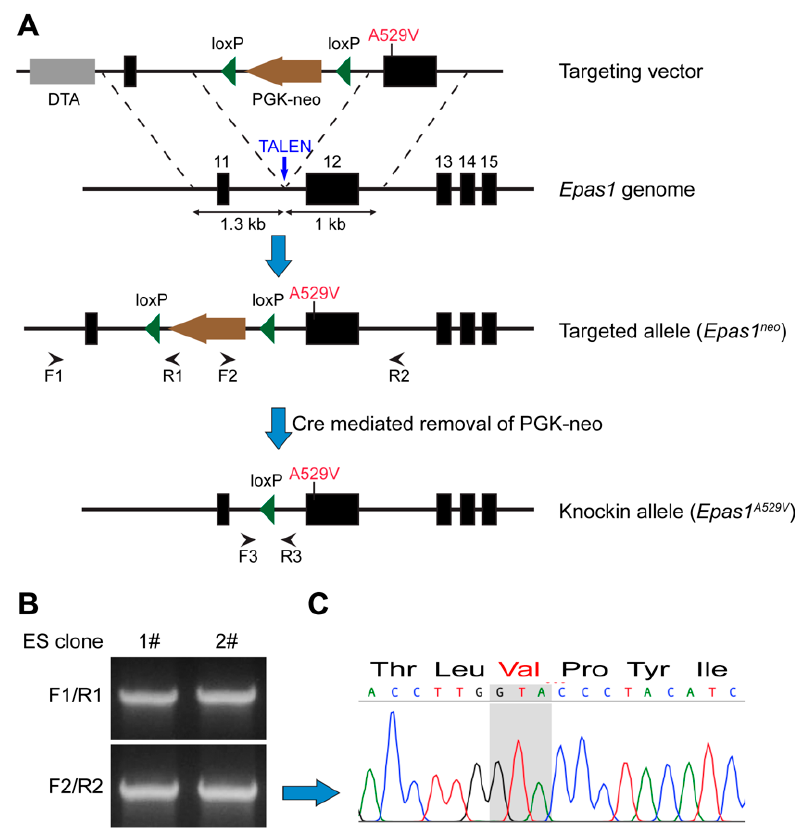
Figure 1. Establishment of the Epas1 A529V animal model. ( A ) Schematic strategy of the mutant mice generation. ( B ) Positive embryonic stem (ES) colonies were confirmed by PCR at both 5 ′ (F1/R1) and 3 ′ (F2/R2) ends. ( C ) Sanger sequencing result of the F2/R2 PCR band. The mutant codon is labeled in red.